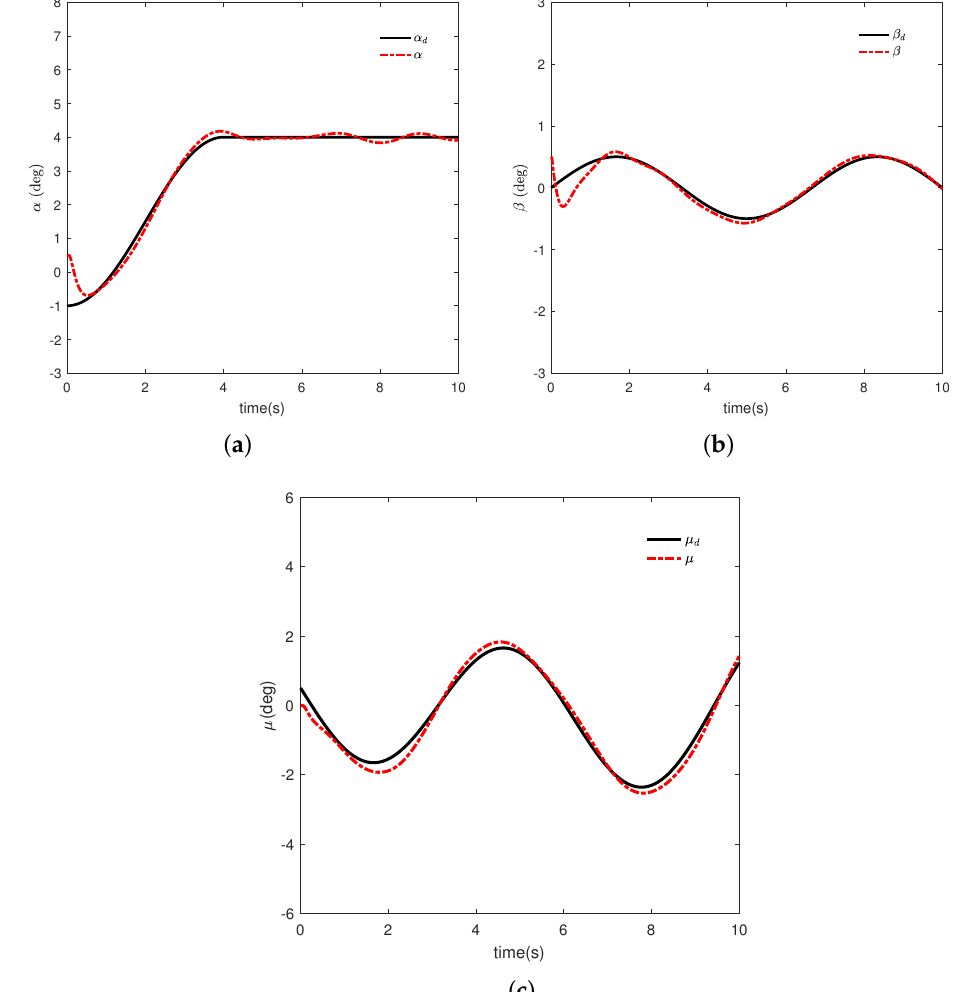
Figure 5. Tracking response curves of attitude angles: ( a ) pitch angle α ; ( b ) yaw angle β ; ( c ) roll angle µ